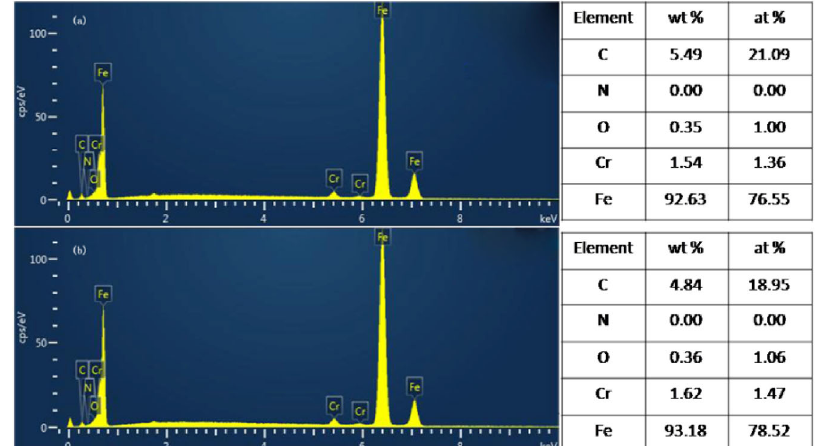
Fig. 8 EDS imaging profiles for the worn steel surface lubricated with (a) [Ch][Gly] and (b) [Ch][Ser].